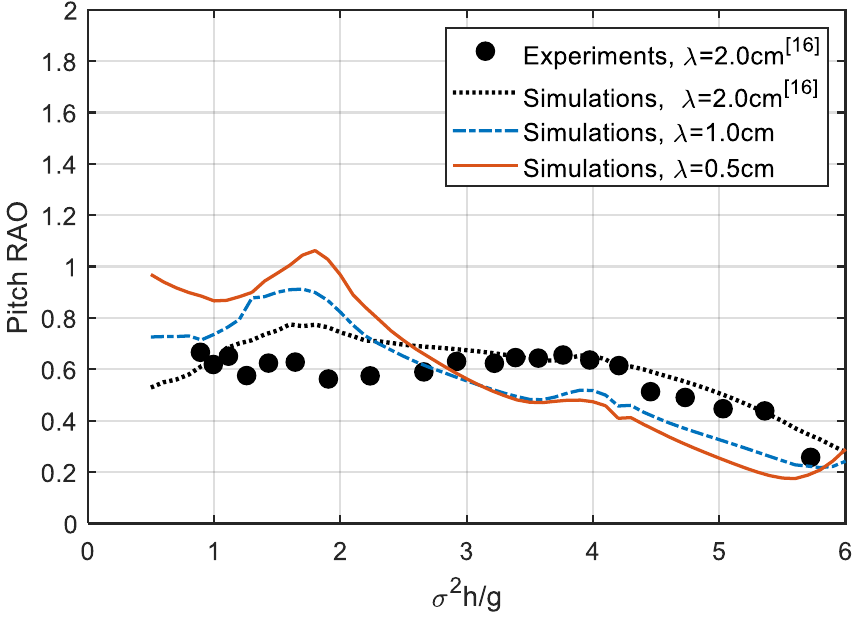
Figure 4. Comparison of the pitch RAO for the platform with various fishnet mesh sizes.